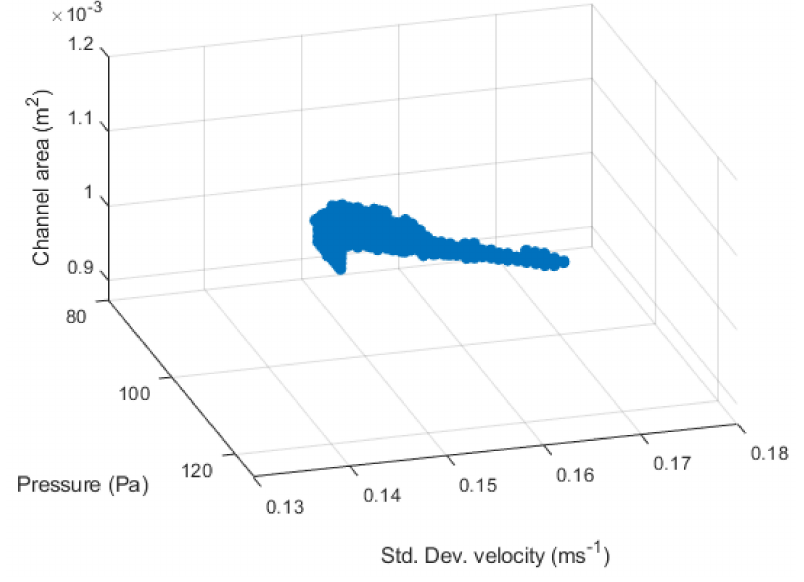
Figure 10. Pareto-front of 11 × 11 flow